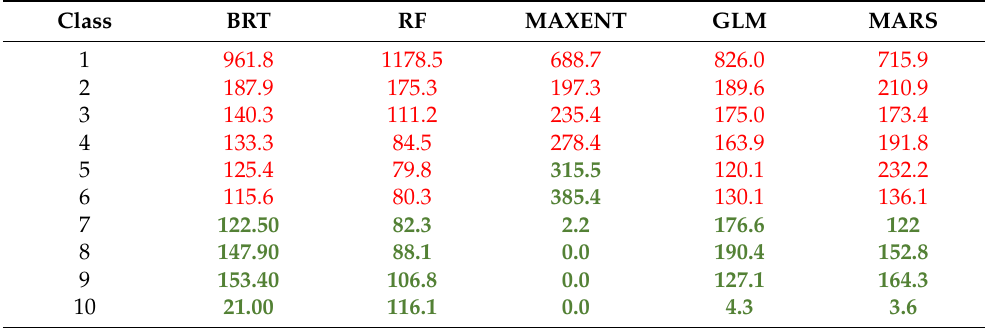
RF model. Table 2. Values of the surface areas (km 2 ) for each class and model: in bold green the presence data, while in red the absence data.